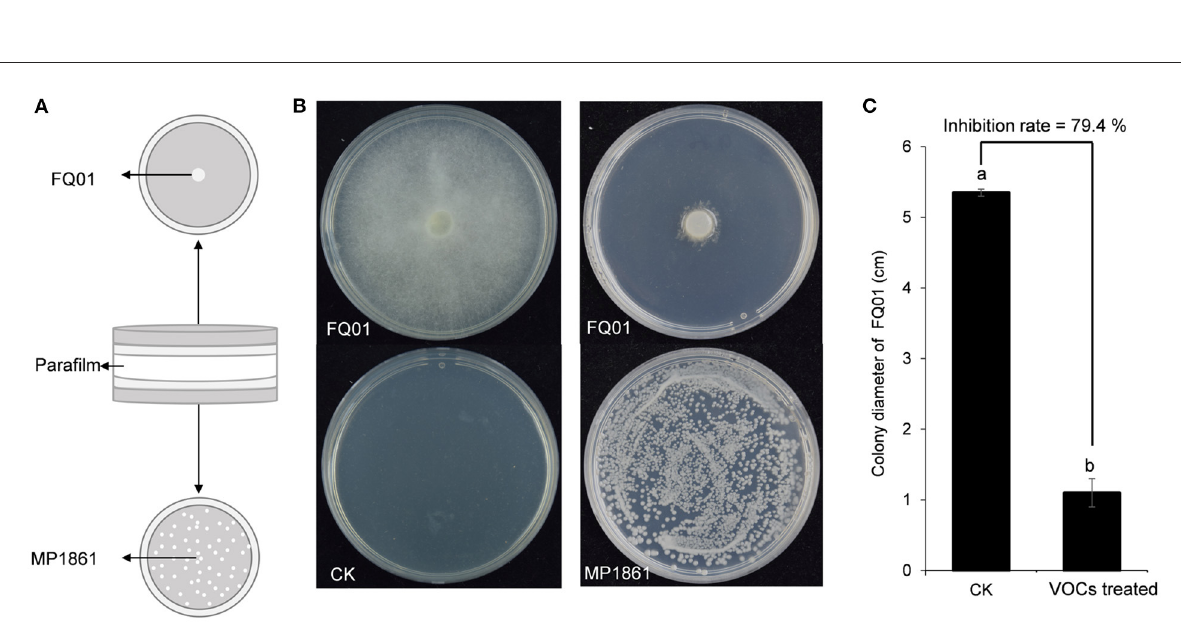
FIGURE3 Graphical representation of VOCs released by the yeast strain MP1861 against the oomycete strain FQ01. (A) Schematic depiction of the method used in this study. (B) Mycelial growth of the pathogen FQ01 grown on PDA plates for 4 d. For the VOCs treated group, each plate was inoculated with 100 µ l of yeast seed (3.0 × 10 4 cells/mL). (C) Colony diameter of the pathogen FQ01. Data are calculated as the mean values ± SD, n = 3. The different letters a and b on the chart indicate significant difference at the 0.05